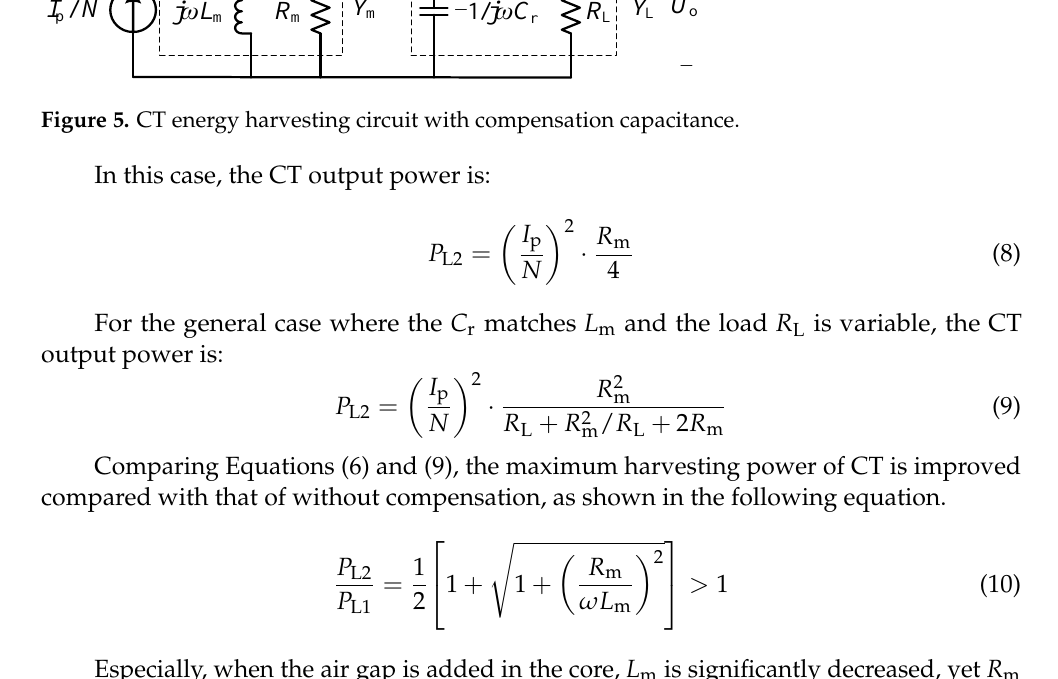
Figure 5. CT energy harvesting circuit with compensation capacitance.